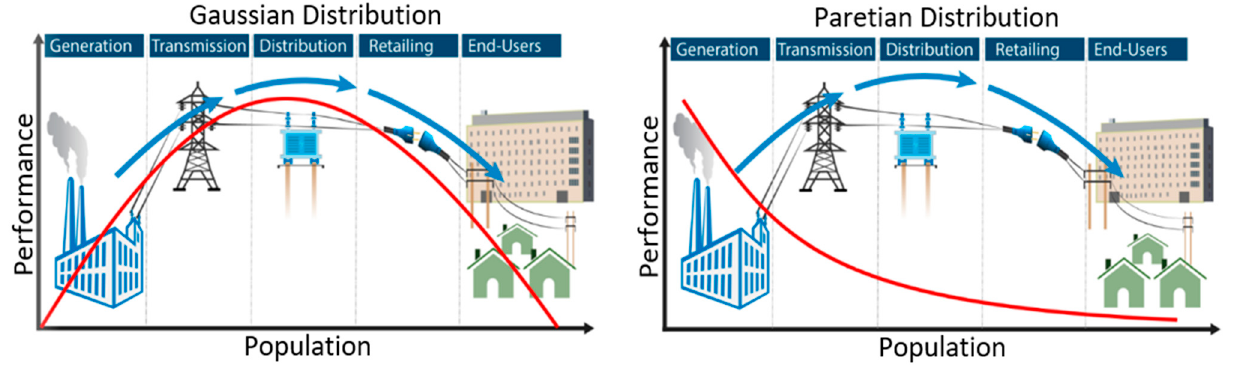
Figure 5. Gaussian and Pareto Approaches